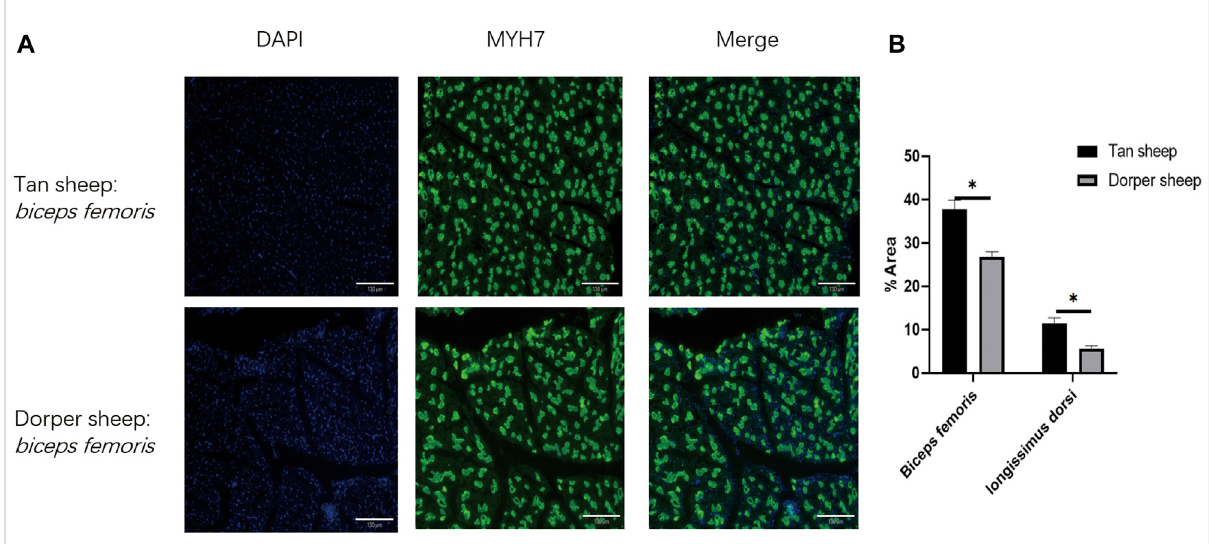
The difference of the slow-twitch fi ber ratio of longissimus dorsi and Biceps femoris muscle between Tan sheep and Dorper sheep. (A) Frozen sections were immuno fl uorescently stained with MyH 17 antibody. “ DAPI ” isa staining solution suitablefor thenuclear staining ofcommoncells and tissues. “ Merge ” is to fuse the stained nucleus with the target protein. (B) Statistical chart of immuno fl uorescence staining